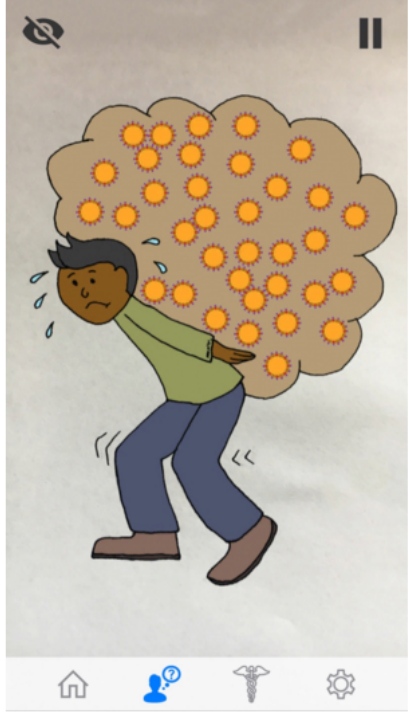
Figure 2. An illustration that appears during the answer to “What is a viral load?” Responding to the question, the avatar explains in a relational way, “You can think of the viral load as the load of virus you’re carrying around. You don’t want to carry around a big load of this virus. Right? So you want the doctor to tell you that your viral load is